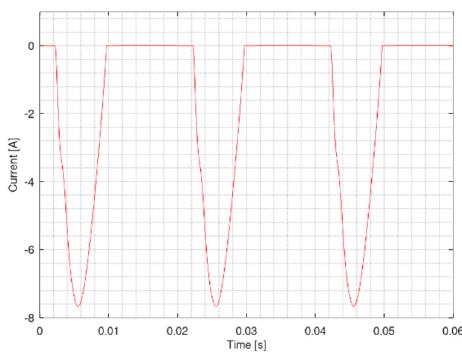
Figure 8. Harmonic spectrum of the voltage across the nonlinear element: ( a ) for the first 50 harmonic orders; ( b ) detailed view of ( a ).